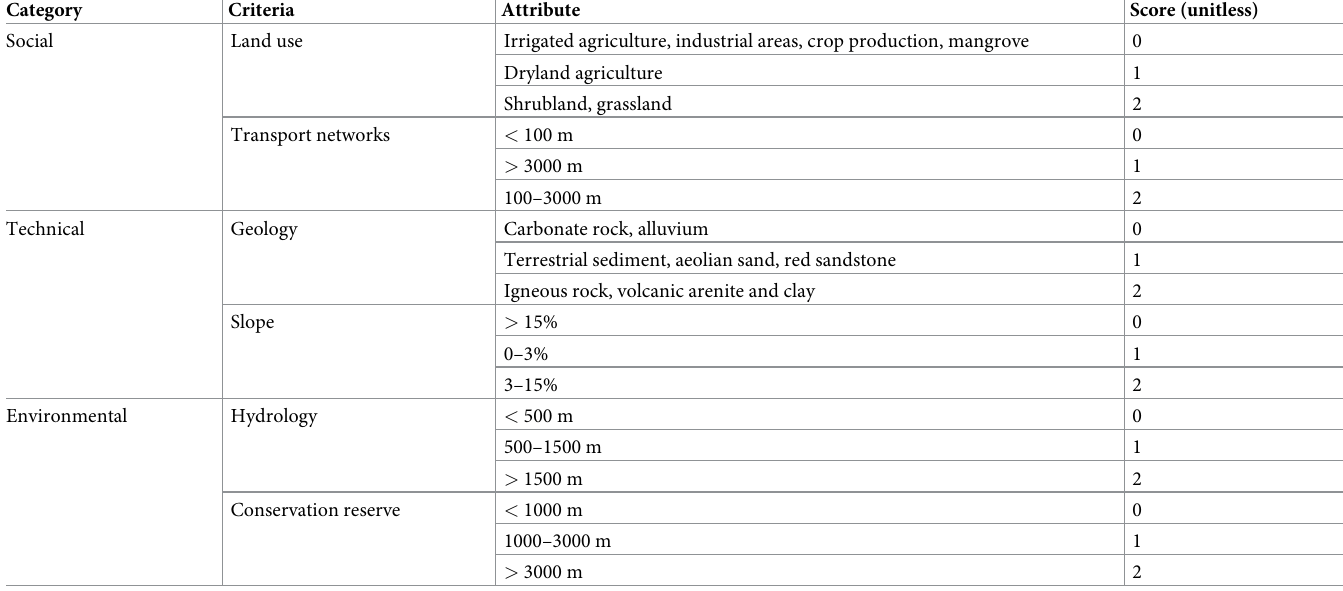
Table 1. Suitability criteria and